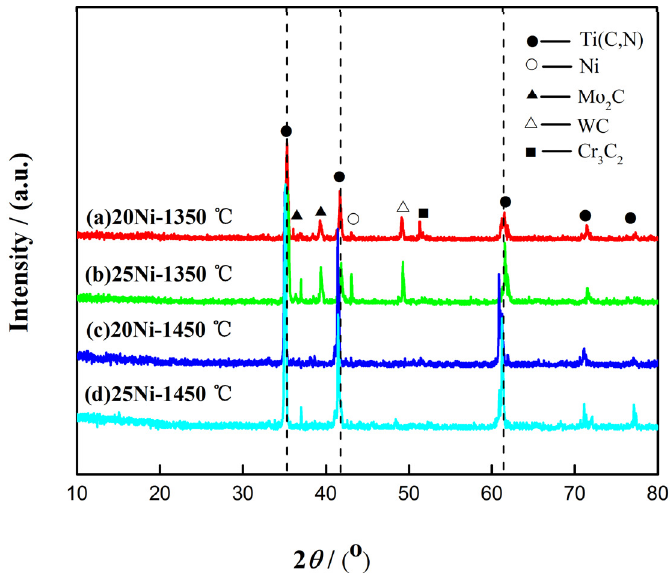
Figure 4. XRD of Ti(C,N)-based cermets: ( a ) 20Ni-1350 °C; ( b ) 25 Ni-1350 °C; ( c ) 20Ni-1450 °C; ( d ) 25 Ni-1450 °C.